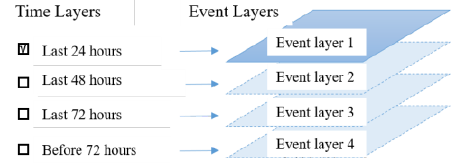
Figure 6. In spatial coordinate system, through superimposing column statistical symbols, point symbols and planar symbols onto basemap, statistical thematic map can